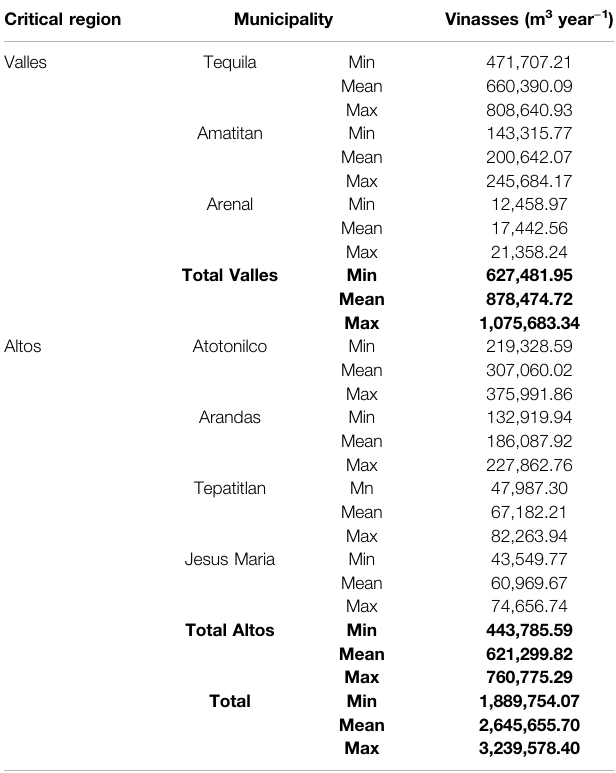
Values presented in bold represent the sum of the values reported for each individual municipaly.